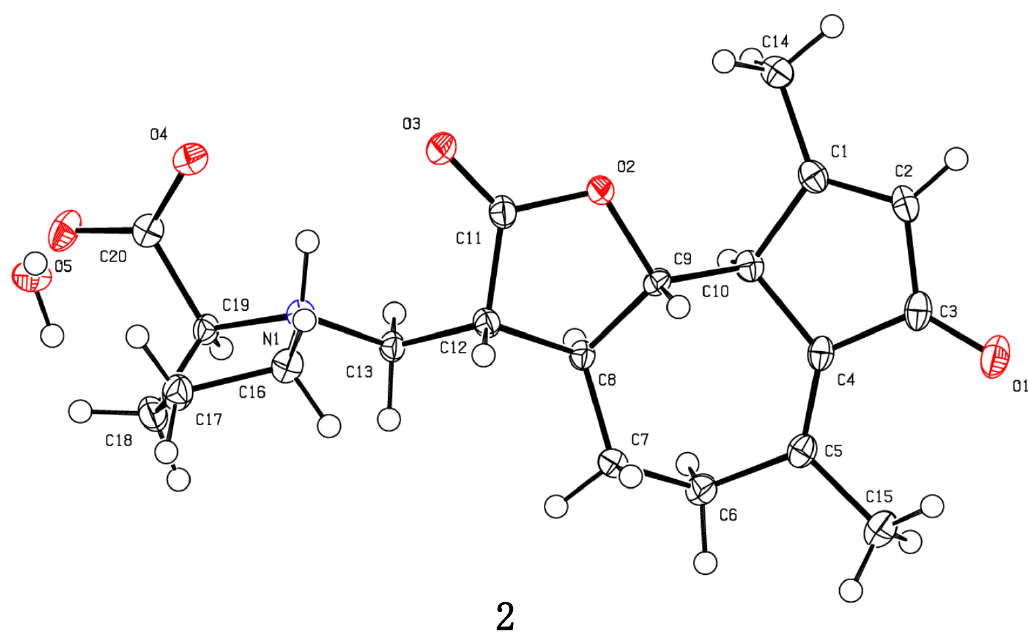
Figure 1. Three dimensional (3D)-ORTEP (name of computer program) projections of the X-ray crystal structure of compound 2 with 50% probability of ellipsoids.